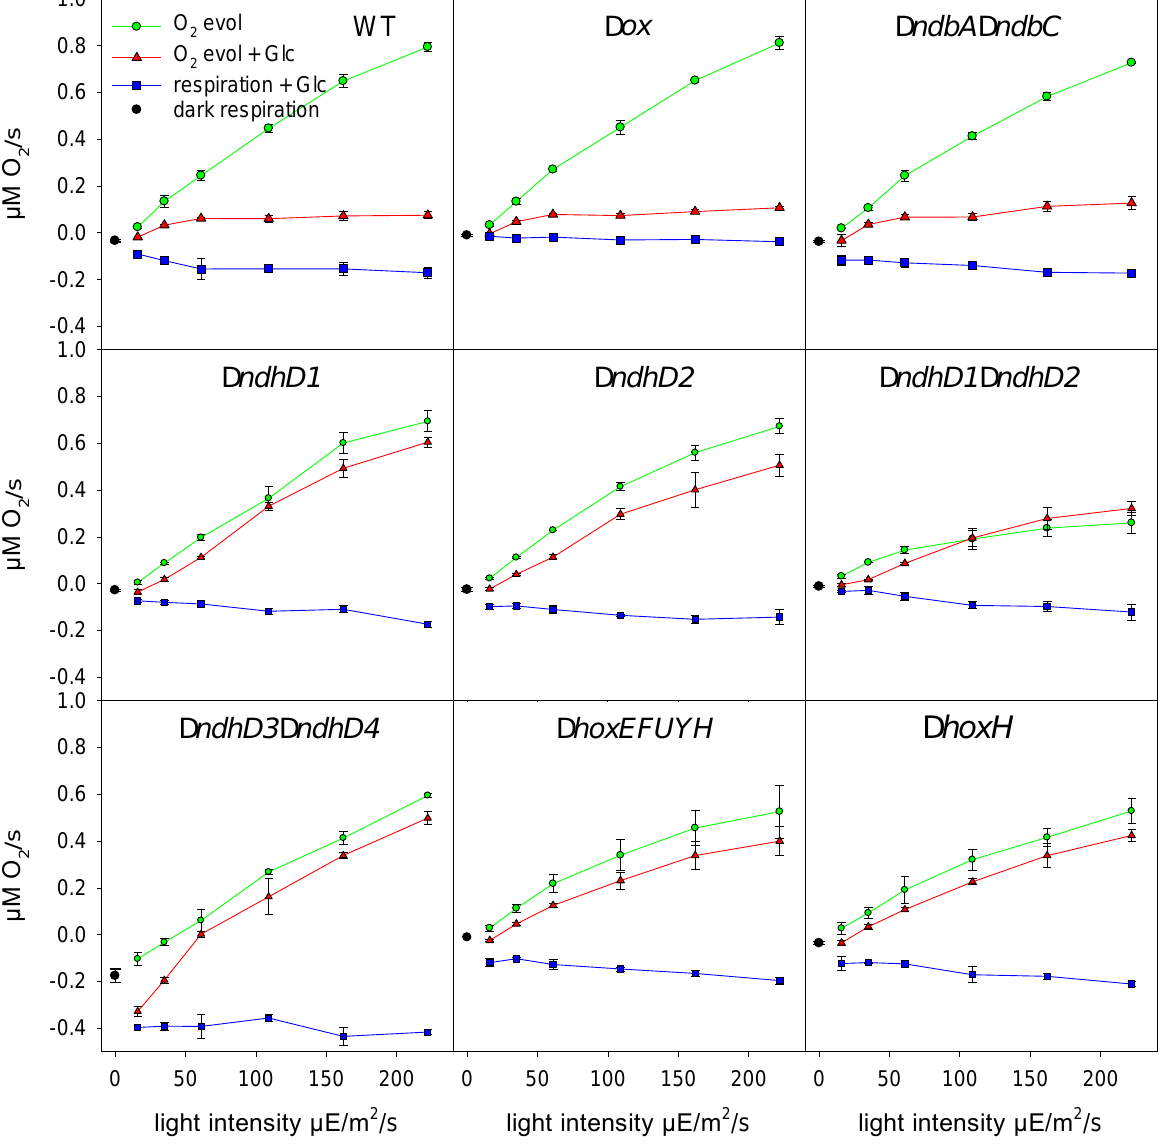
Figure 5. Oxygen evolution without (green lines and circles) and after glucose addition (red lines and triangles) and dark respiration (black circle) and respiration after glucose addition (blue lines and blue squares). The rates are given for a cell density of OD 750 = 5.7. In all cases at least three different cultures of the same strain were measured and their standard deviation is indicated.